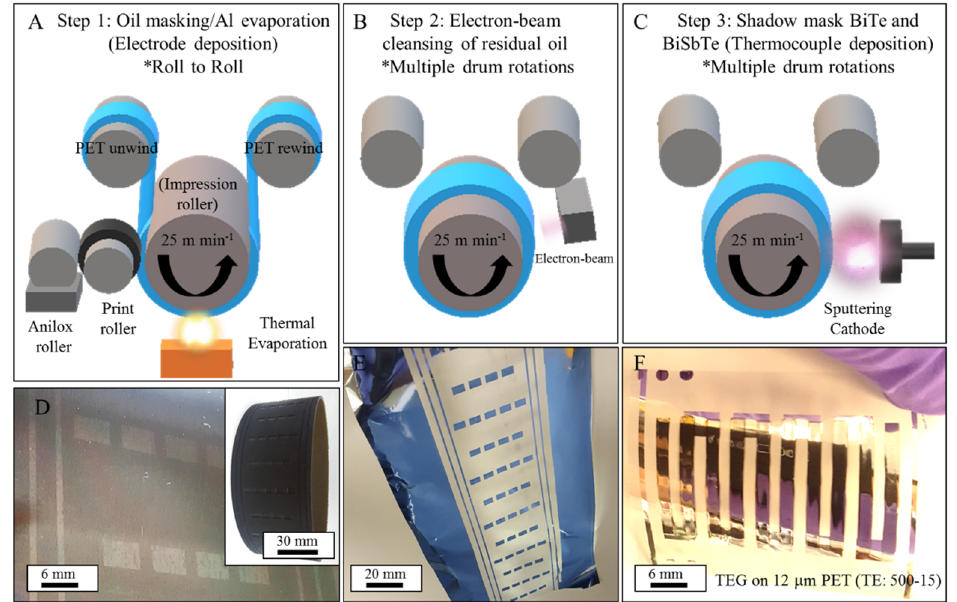
Figure 1. Three-step methodology for producing scalable thermoelectric generators on flexible PET at substrate speeds of 25 m min − 1 . ( A ) Step 1: roll-to-roll Al electrode patterning by flexographic oil masking followed by Al thermal evaporation. ( B ) Step 2: removal of residual oil on PET by electron-beam irradiation. ( C ) Step 3: sputter deposition of thermoelectric semiconductors. ( D ) Printed oil pattern and nitrile print sleeve acquired from Phoenix Printing Plates Ltd. ( E ) Printed electrode section was removed from rewind roll. ( F ) Complete generator on pristine electrodes; TE:500-15. Nomenclature was assigned to manufactured TEGs to denote approximate semiconductor thickness in nm and Electron beam on-time, e.g., TE:500-15 to denote 500 nm and 15 min Electron beam cleaning